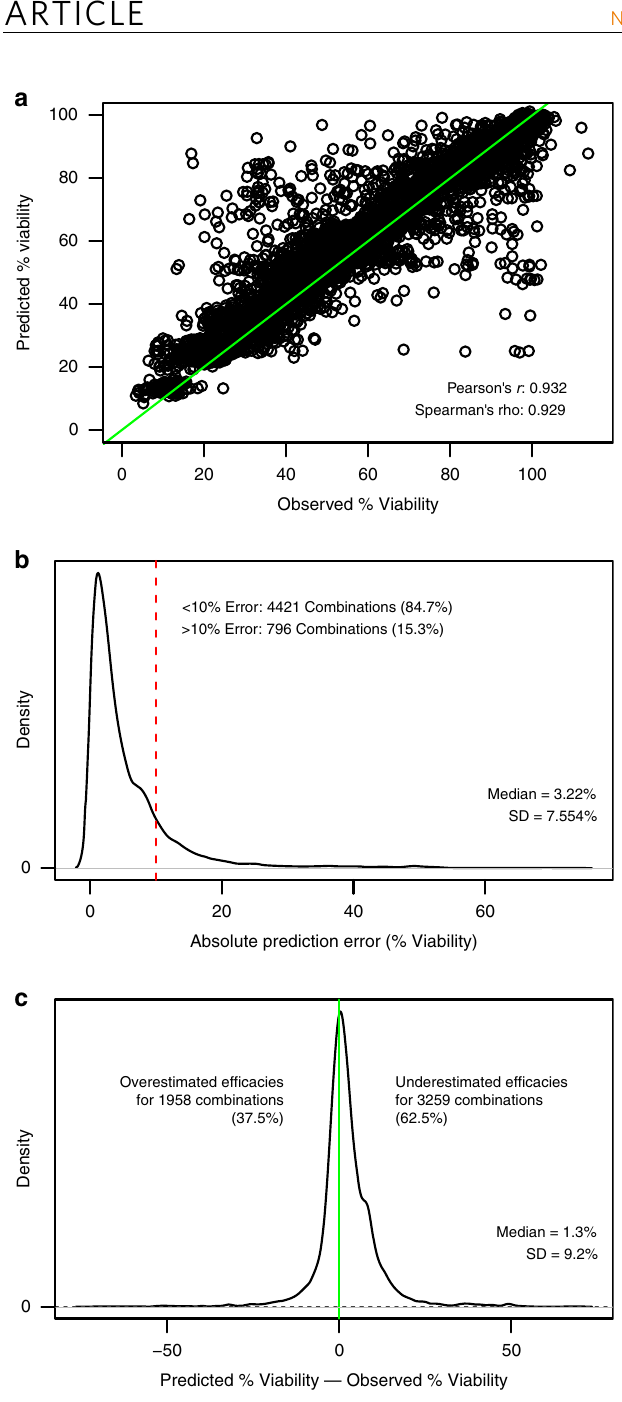
Fig. 2 Agreement between predicted and observed combination viabilities in NCI-ALMANAC. a Scatterplot showing high correlation between predicted average percent viability and experimentally observed average percent viability for each drug combination in NCI-ALMANAC. Predictions were made using monotherapy data from the dataset. The green line is a reference diagonal with slope = 1 and intercept = 0. Note that predictions were only made for the maximum concentration tested for each drug. b Density plot showing that the absolute values of the differences between the predicted percent viabilities and the observed percent viabilities for each drug combination are generally below 10%, with >50% of drug combinations having an absolute prediction error below 5%. The red line marks a difference of ±10% viability between predicted and